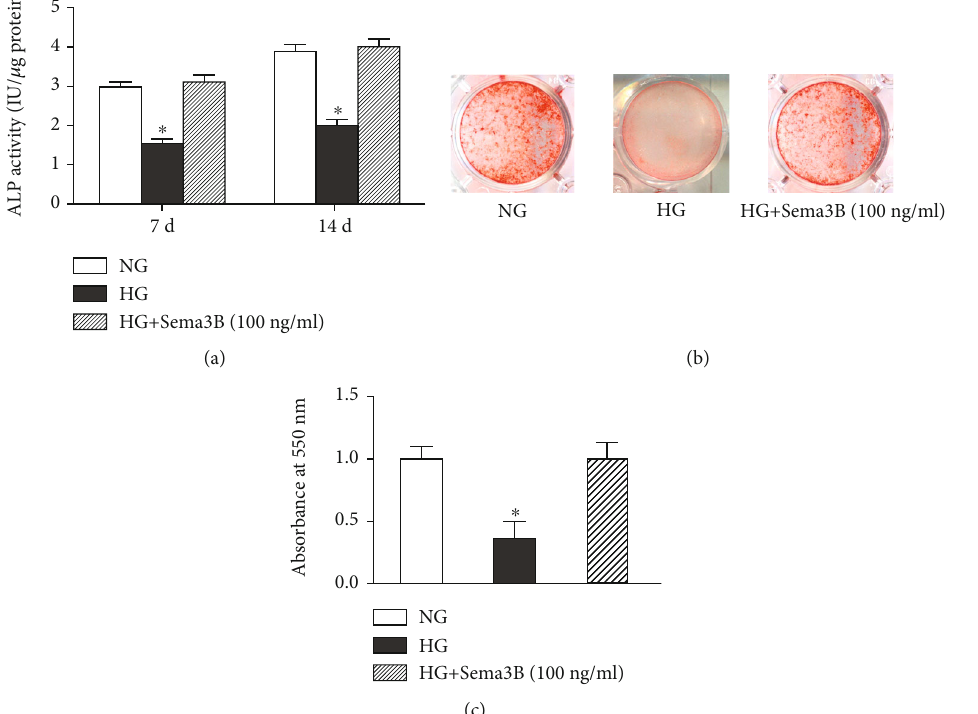
Figure 5: E ff ects of Sema3B on osteogenic di ff erentiation under HG treatment. (a) ALP activity is presented as the mean ± SEM ( n = 3 ). (b) Alizarin red S staining. (c) Quanti fi cation of alizarin red staining. The results of alizarin red staining are presented as the mean ± SEM ( n = 3 ). ∗ P < 0 : 05 compared to the other